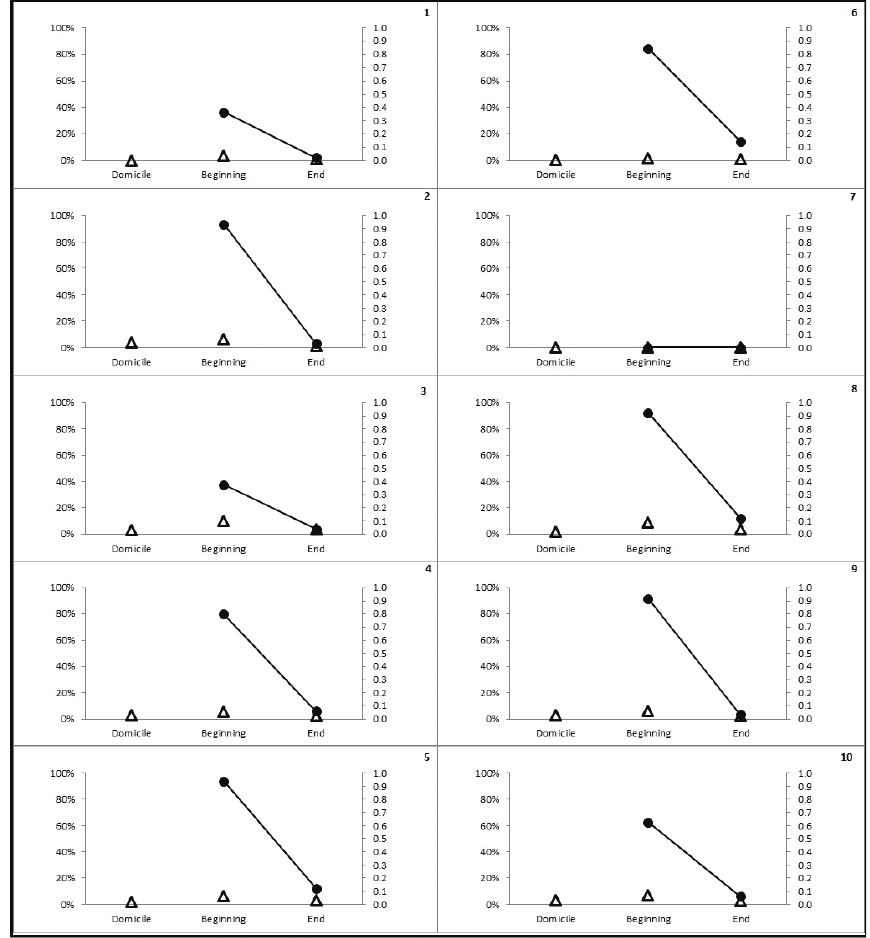
Fig.1. Immunohistochemical expression of TIMP-2 / OSCC negative